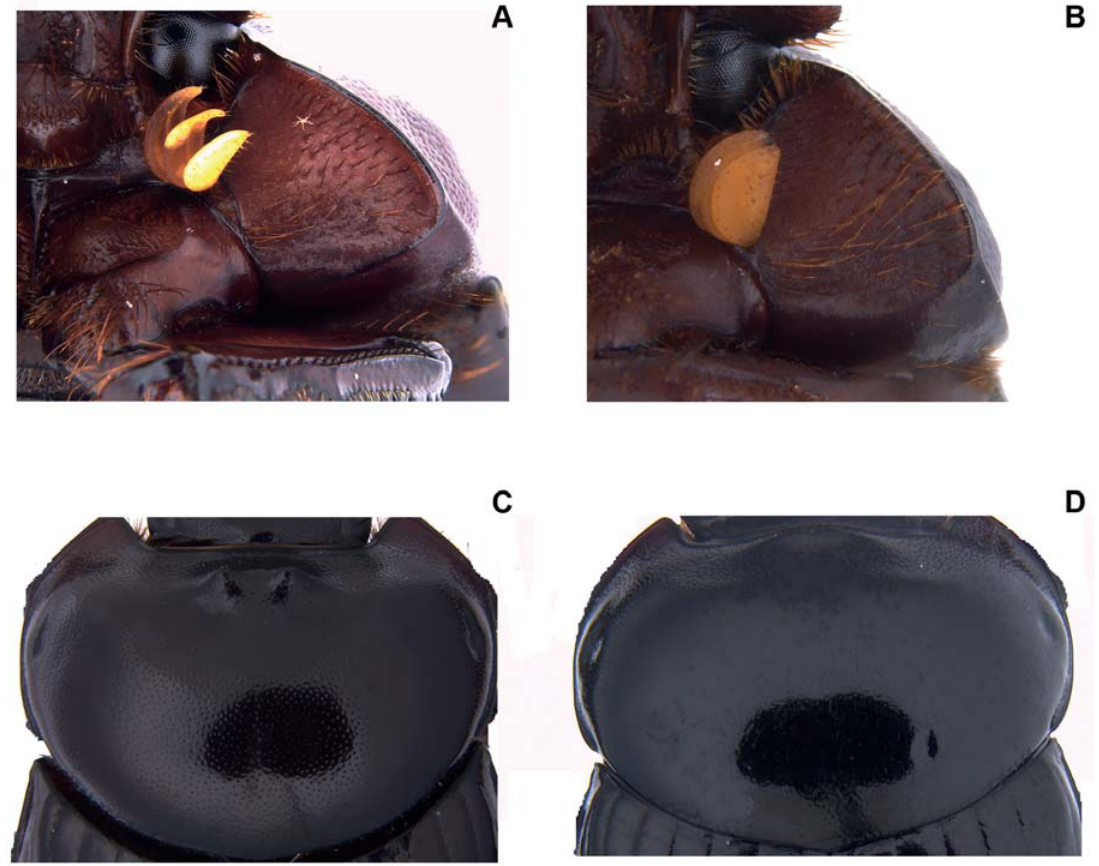
Fig. 1. A . Canthidium gigas Balthasar, 1939 , hypomerum with complete hypomeral carina. B . Canthidium kelleri (Martínez et al ., 1964) , hypomerum with incomplete hypomeral carina. C . Disc of pronotum completely punctated. D . Disc of pronotum with inde fi nite punctation. Not to